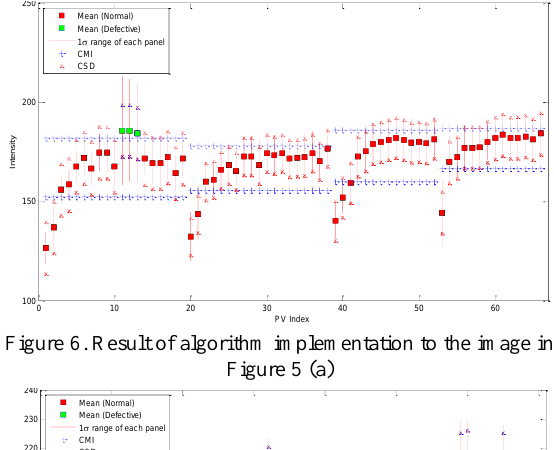
Figure 6. Result of algorithm implementation to the image in Figure 5 (a)